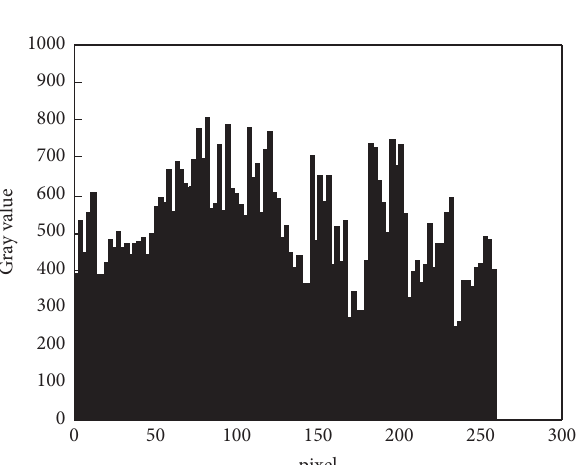
Figure 3: Histogram equalization processing.